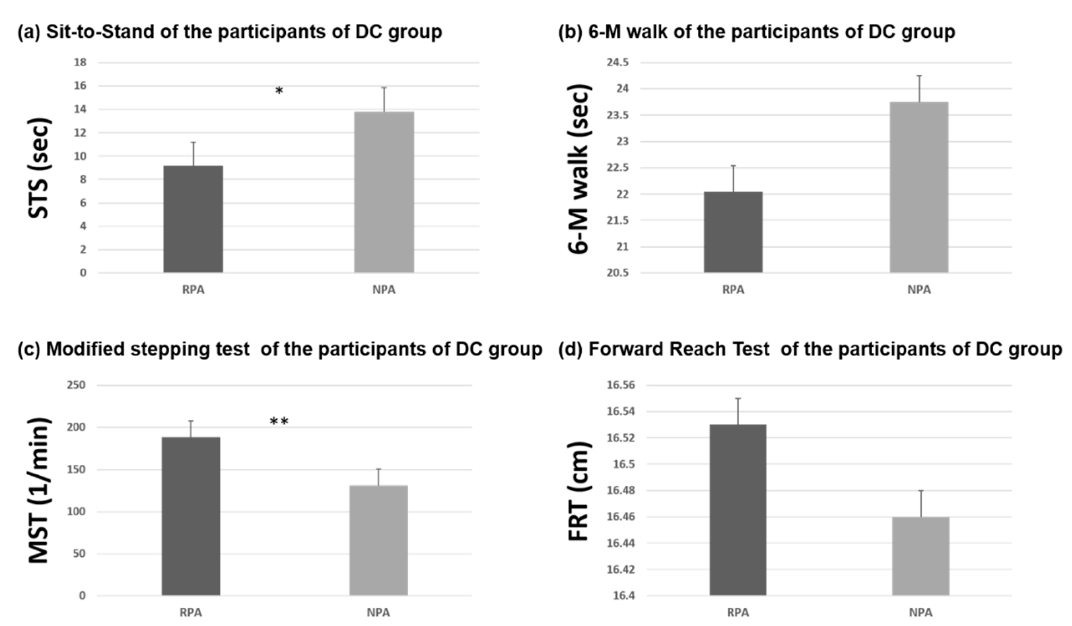
Figure 3. Functional test of ( a ) sit to stand test, ( b ) 6-meter walking test, ( c ) modified stepping test and ( d ) forward reach test of the participants of DC group; * p < 0.05; ** p < 0.05.